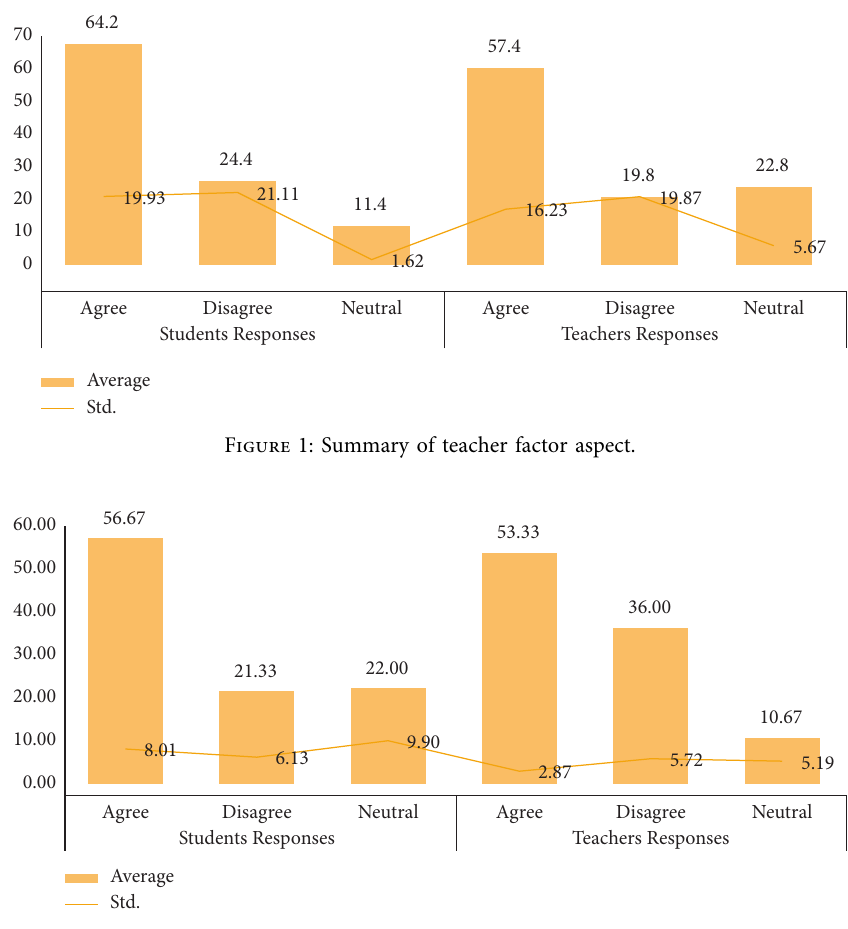
Figure 2: Summary of school facilities